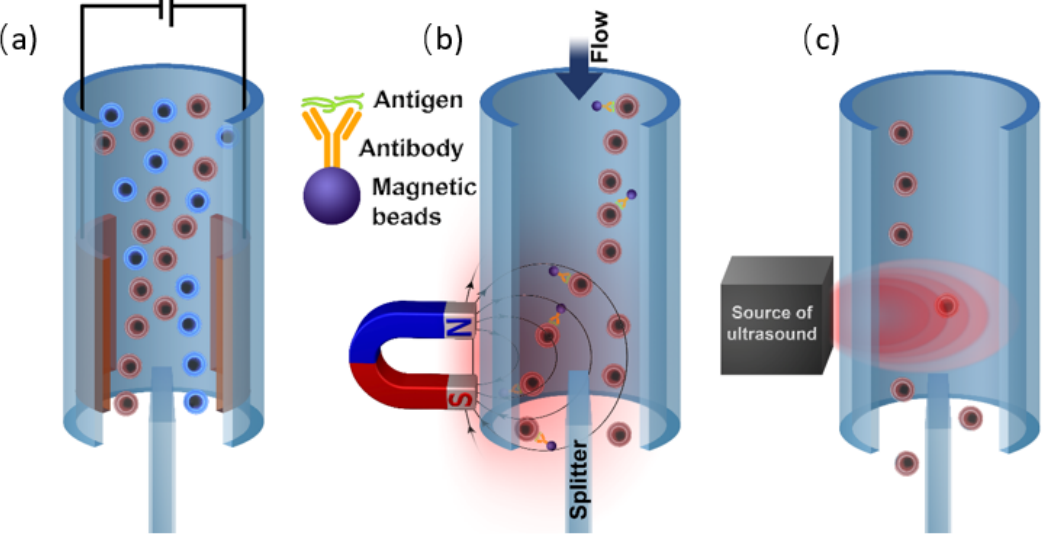
Figure 9. Various types of separation microfluidic mechanisms: ( a ) electrokinetic; ( b ) magnetic; and ( c ) acoustic